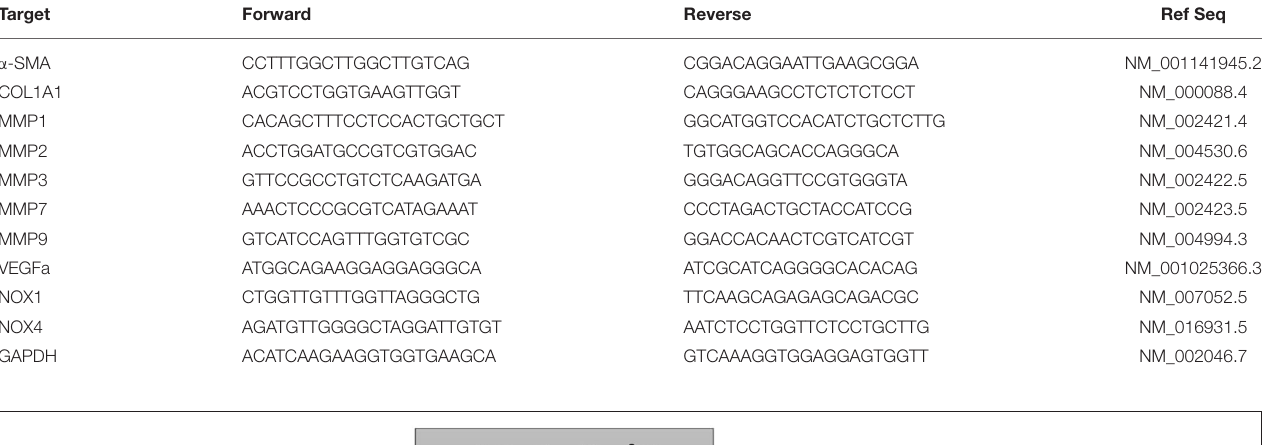
TABLE 3 | Primers for qRT-PCR analysis performed on human cell lines.